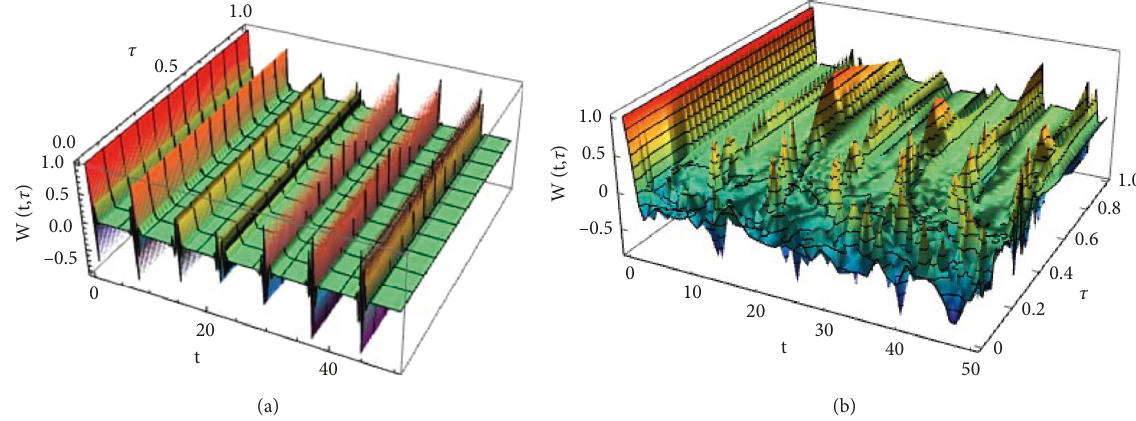
Figure 3: W t, τ as a function of the scaled time t and the classical field parameter τ , ( )